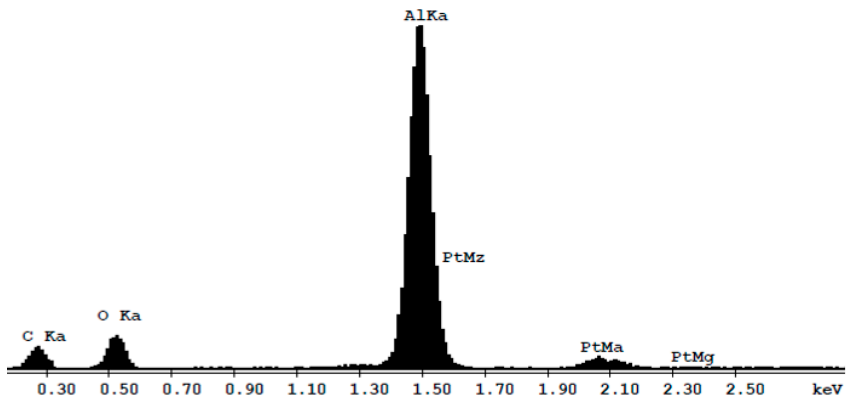
Figure 2. Energy Dispersive X-ray spectroscopy (EDX) of nano-porous Al 2 O 3 . Material is composed of aluminum (Al) and oxygen (O). The presence of platinum (Pt) is related to the metallization of the sample for FESEM analysis. The presence of the carbon (C) is due to sample contamination. Table 1. The pore size distribution over the cross-section of the sample and on the surface. Table 2. Relative elemental concentrations found on the specimens are given in wt % (weight percent) and in at % (atomic percentage). Pt was used to metallize the samples before FESEM